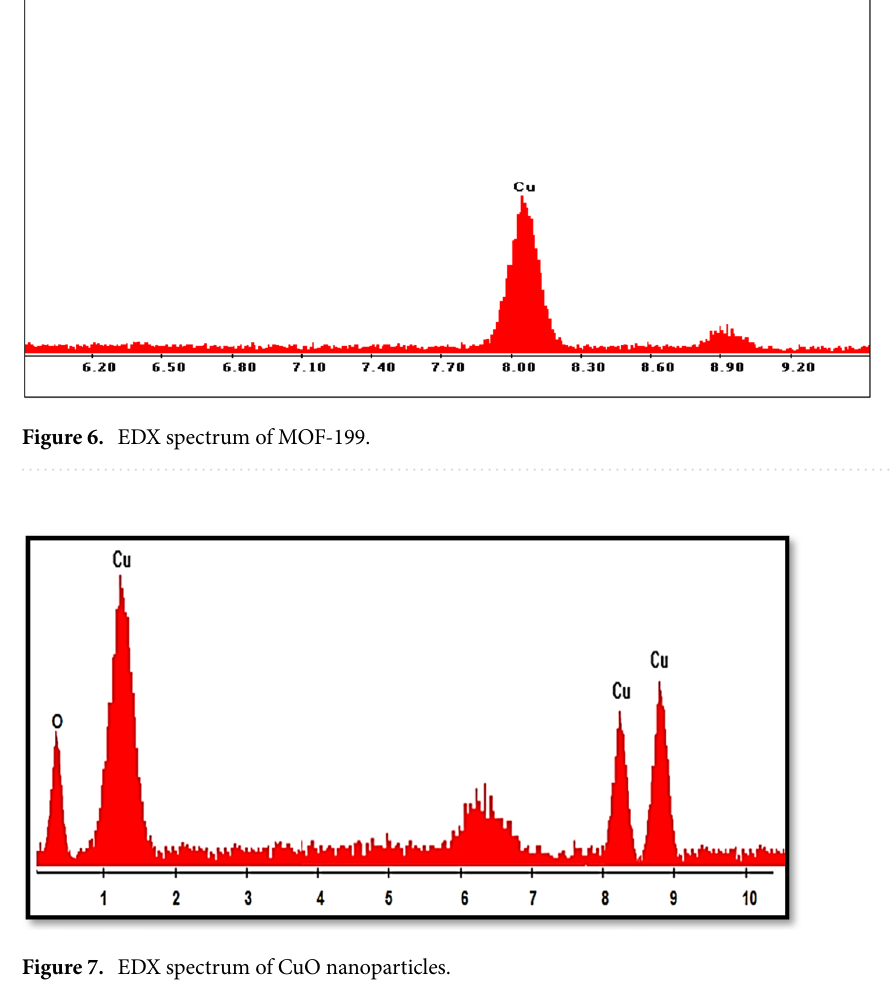
Figure 7. EDX spectrum of CuO nanoparticles.